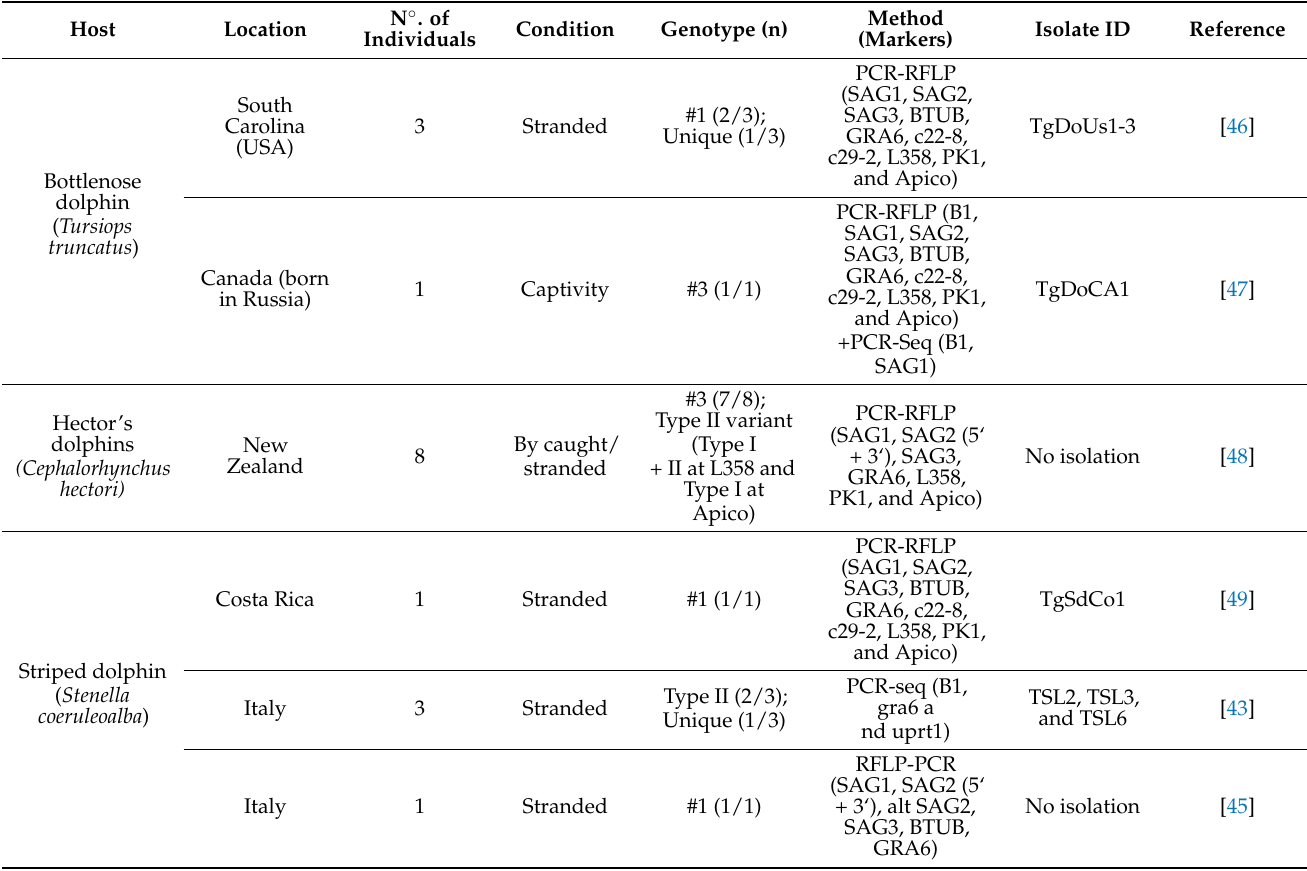
Table 3. Summary of the available literature reporting genotyping data on Toxoplasma gondii strains infecting dolphins.